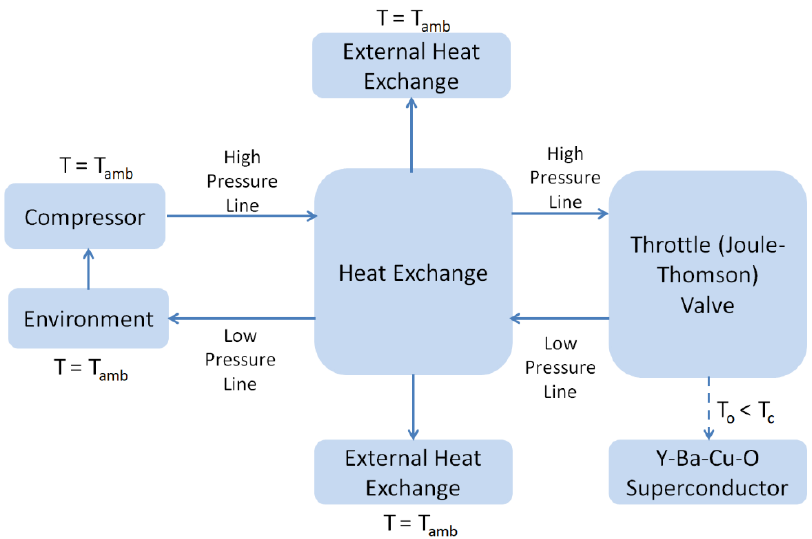
Figure 13. Hampson ‐ Linde process block diagram. Figure 13. Hampson-Linde process block